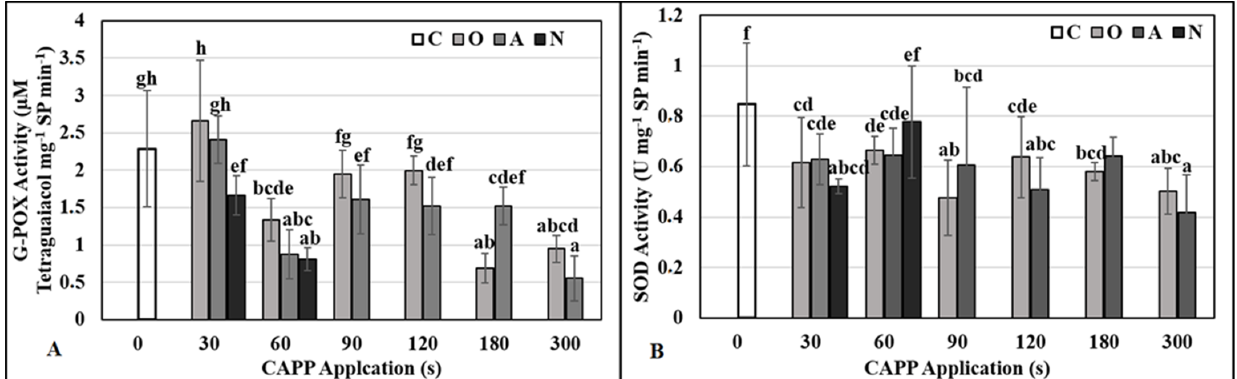
Figure 6. The activity of guaiacol peroxidase (G-POX) ( A ) and superoxide dismutase (SOD) ( B ) in 3-day-old maize seedlings after Cold Atmospheric Pressure Plasma (CAPP) treatment of grains. Variants: C—control/untreated maize grains; O30 ‒ O300: maize grains treated with plasma generated in an oxygen atmosphere for 30, 60, 90, 120, 180 or 300 s; A30 ‒ A300: maize grains treated with plasma generated in ambient air for 30, 60, 90, 120, 180 or 300 s; N30 ‒ N300: maize grains treated with plasma generated in a nitrogen atmosphere for 30, 60, 90, 120, 180 or 300 s. In the case of N90 variant seedlings lagged significantly in development and in N120 ‒ 300 variants, the maize grains did not germinate, so they are not shown in the graph. Different letters indicate significant difference at p -value < 0.05, bars are means of ten experimental runs (one run represents 50 grains per variant; three 1.5 g mixed samples were analyzed per one experimental run and each variant for guaiacol peroxidase and superoxide dismutase activities) ± SD according to LSD ANOVA test.